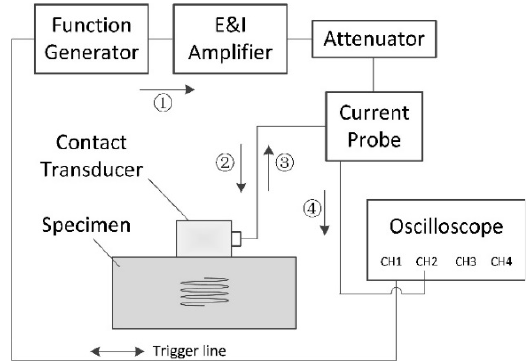
Figure 2. Experimental setup for pulse-echo nonlinear method. Serial numbers are used to denote the transfer order of signals.